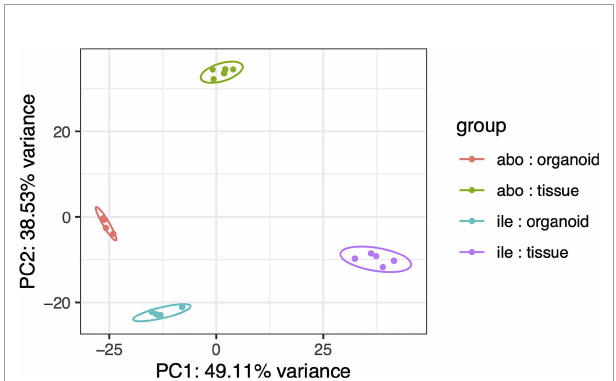
FIGURE 5 | Principal component analysis (PCA) of RNA-seq expression of the top 500 most variant genes (of genes ranked by inter-sample variance) in ovine abomasum and ileum organoid and tissue samples. Sample type is indicated in the key and includes: abomasum organoid (red); abomasum tissue (green); ileum organoid (blue); ileum tissue (purple). Ellipses indicates 95% con fi dence intervals for each